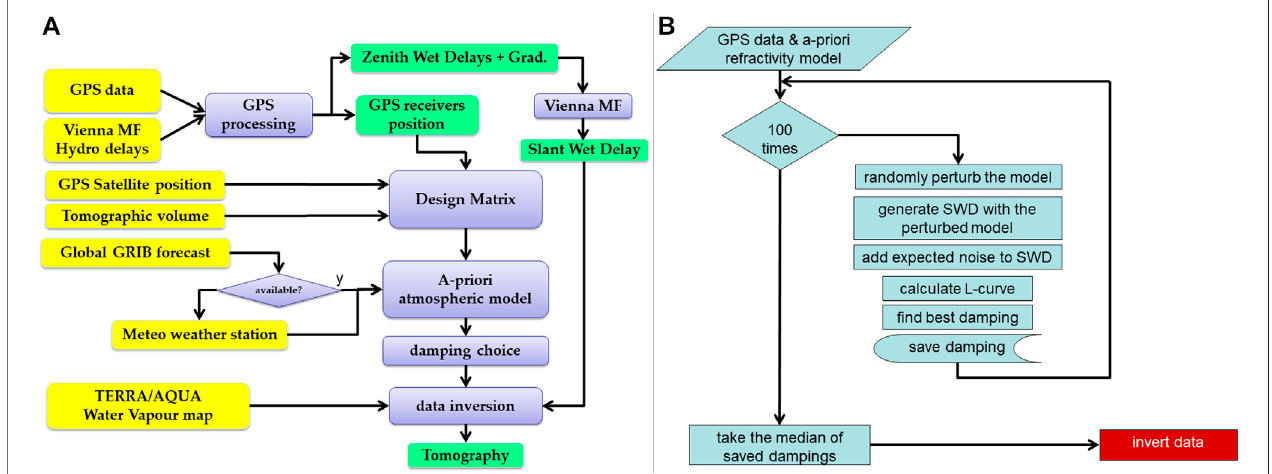
FIGURE1|(A) Block diagram oftheprocessingchain.Inyellow,theblocks withexternal data;in violet,theprocessing blocks; ingreen, theblocks withcalculated parameters from GPS and the block of fi nal inversion for tomography calculation. (B) Zoom of the “ damping choice ” block: fl ow diagram of the algorithm to estimate a damping factor for a robust tomography. The damping factor followed an iterative process: for each iteration, we selected the best damping factor (by L-curve) to reconstruct a randomly perturbed model where real measured noise was added. The single L-curve was calculated in a fi xed set of 10 damping values. At the end of the process, the damping factor used for the real data inversion was the median of the ones obtained from the iterations.